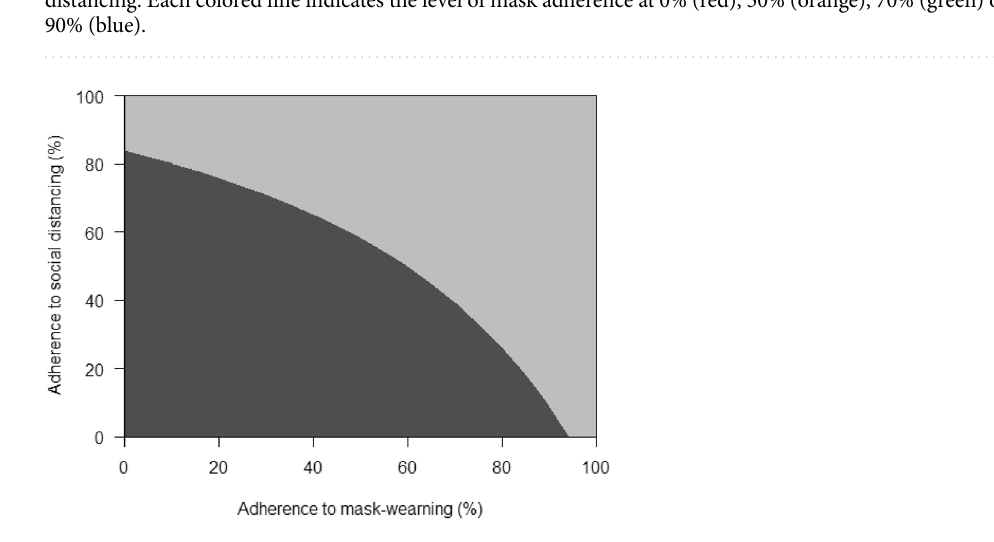
Figure 5. Threshold analysis of adherence necessary to prevent any reinstatement of stay-at-home restrictions between June 2020 and May 2021 in NYC. Dark grey region corresponds to a range of adherence to social distancing and mask-wearing which necessitates the reinstatement of stay-at-home restrictions, while light grey region corresponds to a range avoiding any reinstatement of stay-at-home